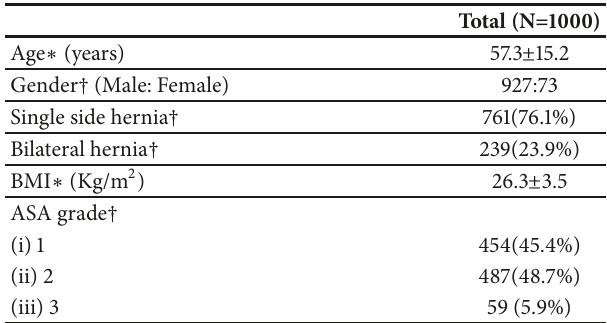
Table 1: Baseline characteristics of the study’s